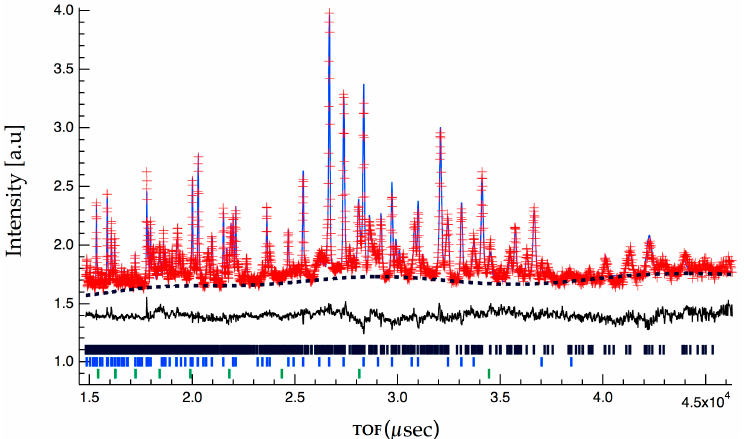
Figure 3. Fit to neutron data; observed and calculated data are red crosses and the continuous blue line, respectively. The dotted and solid black curves represent the background and the difference between observed and calculated data, respectively. The vertical black, blue and green lines mark the positions of Bragg reflections from the Ga-Ti-O-N, TiO 2 (rutile) and vanadium sample can, respectively. The largest differences between observed and calculated data are in the rutile phase.